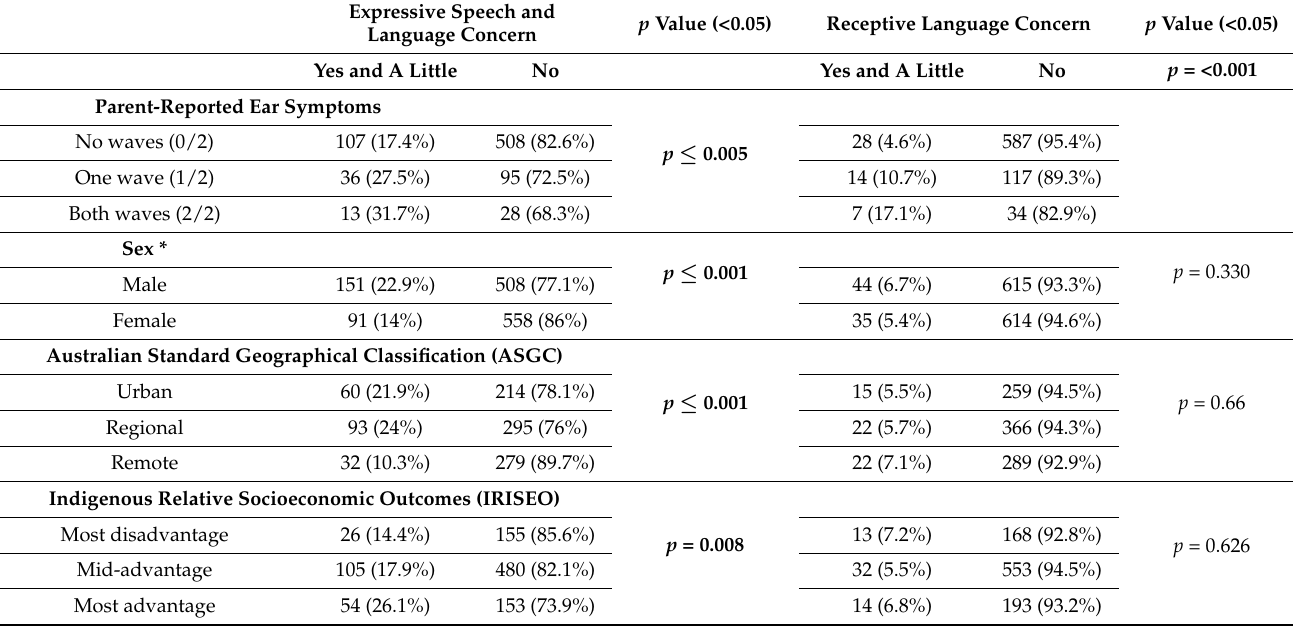
Table 1. Chi-square analysis of covariates by parent-reported concern about expressive and receptive speech and